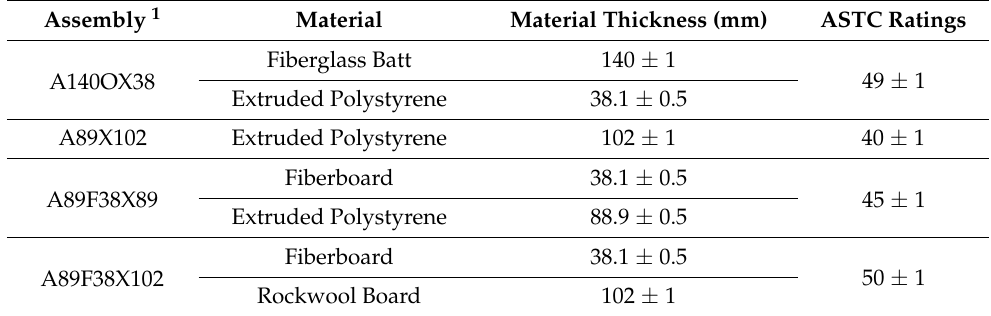
Table 5. The ASTC ratings of the tested assemblies.